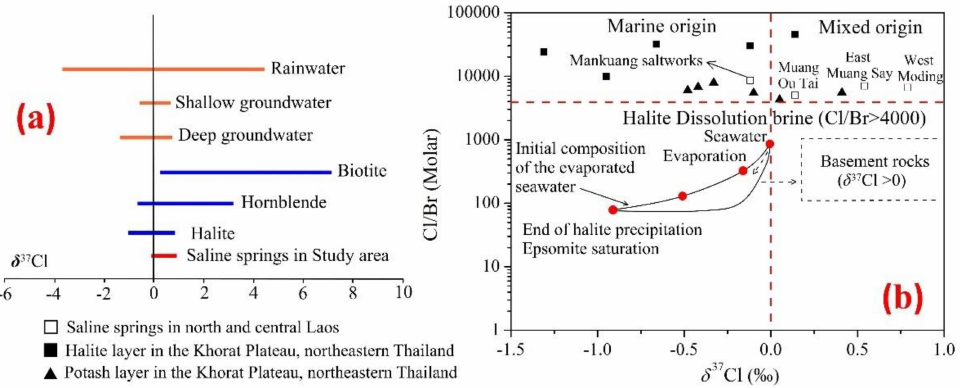
Figure 10. ( a ). The range of variation of δ 37 Cl in different fluids and saline minerals. Data sources: Rain water [121]; shallow and deep groundwater [123]; biotite [37]; hornblende and halite [120]. ( b ) Relationship between the Cl/Br molar ratios and δ 37